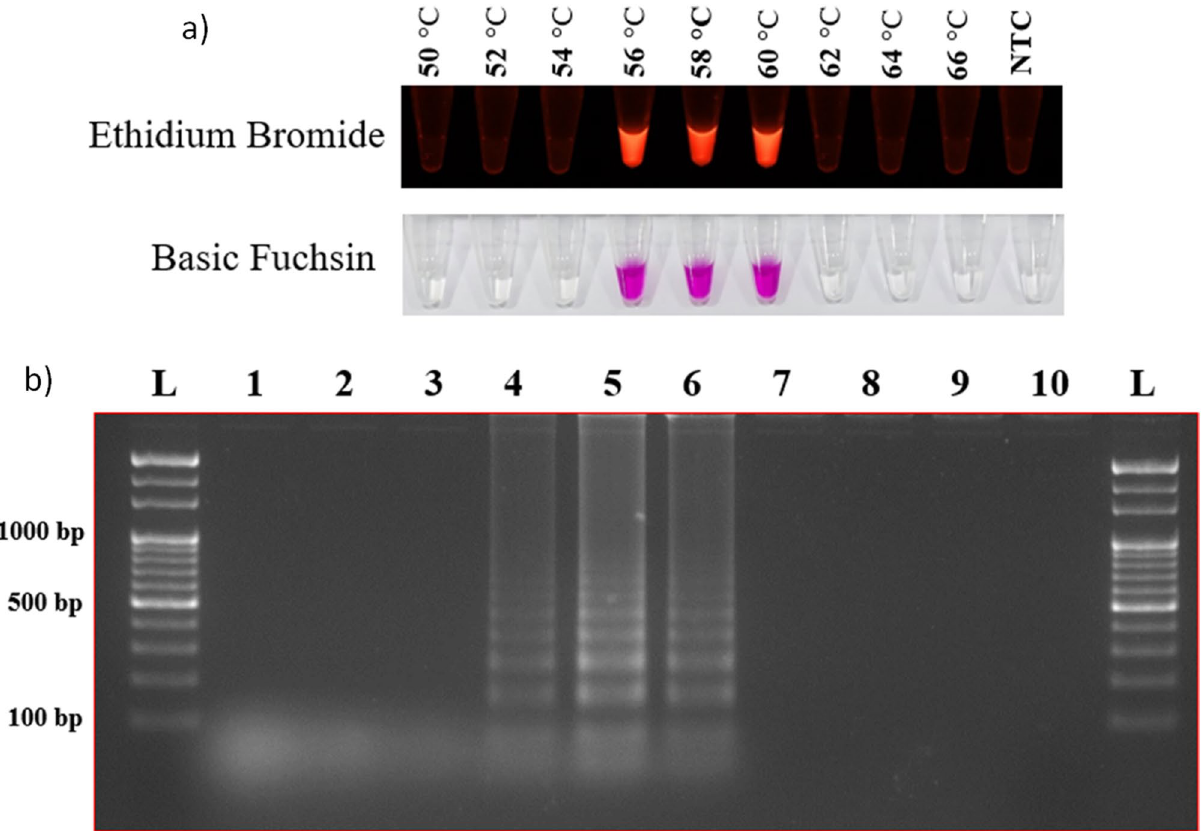
Figure 1. Reaction temperature optimization. ( a ) Temperature optimization (ranged between 50 to 66 °C) for the LAMP assay with Ethidium bromide and basic fuchsin dyes. ( b ) Further, results were visualized on a 2% agarose gel. Where lanes 1 to 9 indicate the temperature in °C (50, 52, 54, 56, 58, 60, 62, 64, and 66), lane N indicates negative control, and Lane L indicates 1 kb ladder (Thermo Scientific,